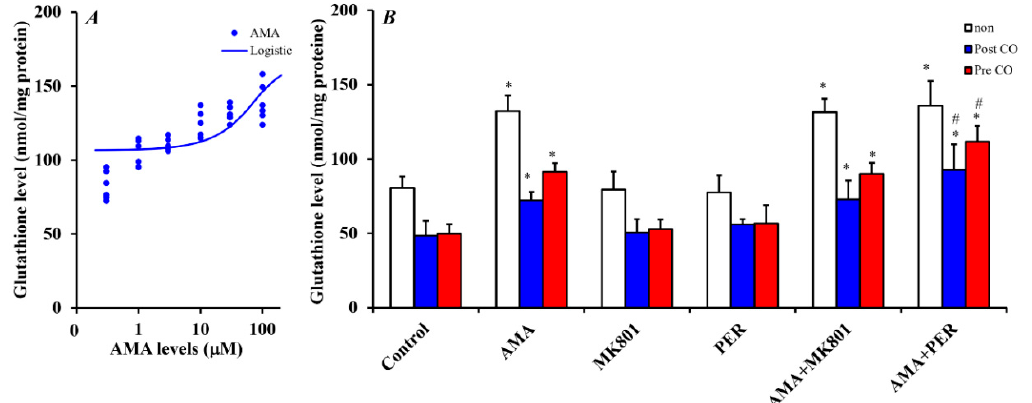
Figure 6. ( A ) Concentration-dependent effects of AMA administration (0~100 μ M) for 7 days on the intra-astroglial glutathione level. Ordinate; mean ± SD ( n = 6) of intra-astroglial glutathione level (nmol/mg protein); abscissa: concentration of AMA ( μ M) (logistic regression analysis). ( B ) Effects of AMA (10 μ M), MK801 (1 μ M) and PER (1 μ M) on the intra-astroglial glutathione level in physiological conditions (non carbon monoxide (CO)), after CO-exposure administration (post CO) and before CO-exposure administration (pre CO). Ordinate; mean ± SD ( n = 6) of intra-astroglial glutathione level (nmol/mg protein). * p < 0.05 relative to the control by two-way analysis of variance with Tukey’s post hoc test; # p < 0.05 relative to the AMA administrations by two-way analysis of variance with Tukey’s post hoc test [F agent (5,90) = 94.4 ( p < 0.01), F CO (2,90) =151.4 ( p < 0.01), F agent*CO (10,90) = 4.0 ( p < 0.01)].